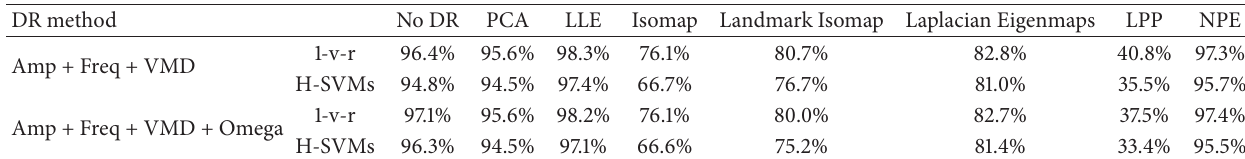
Table 5: Classification results with different DR methods.